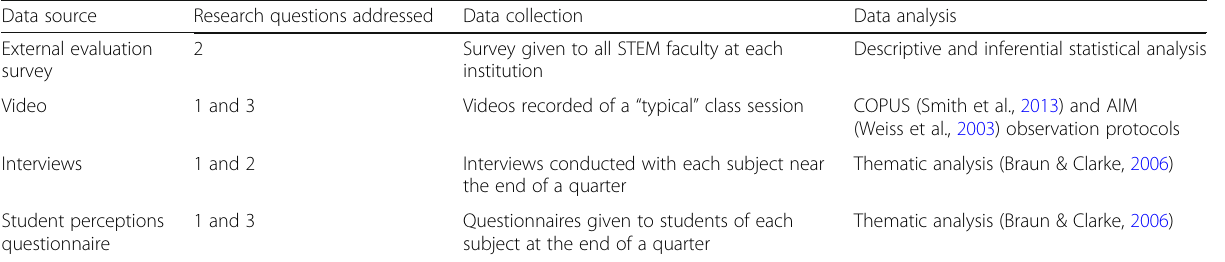
Table 1 Summary of the data collection and analysis for each research question Data